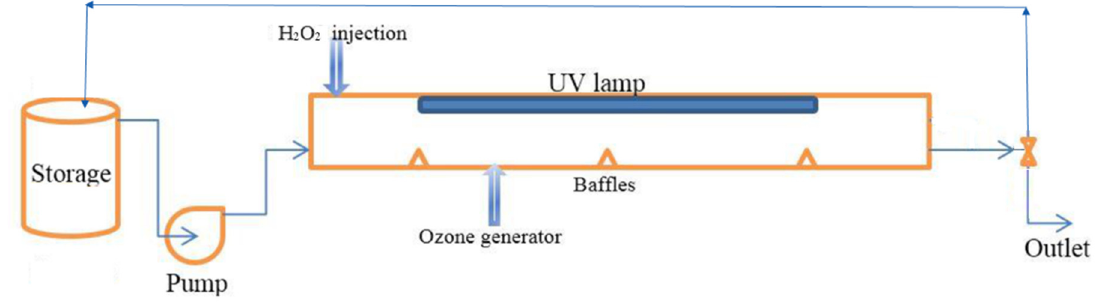
Figure 2. The schematic view of the disinfecting system.